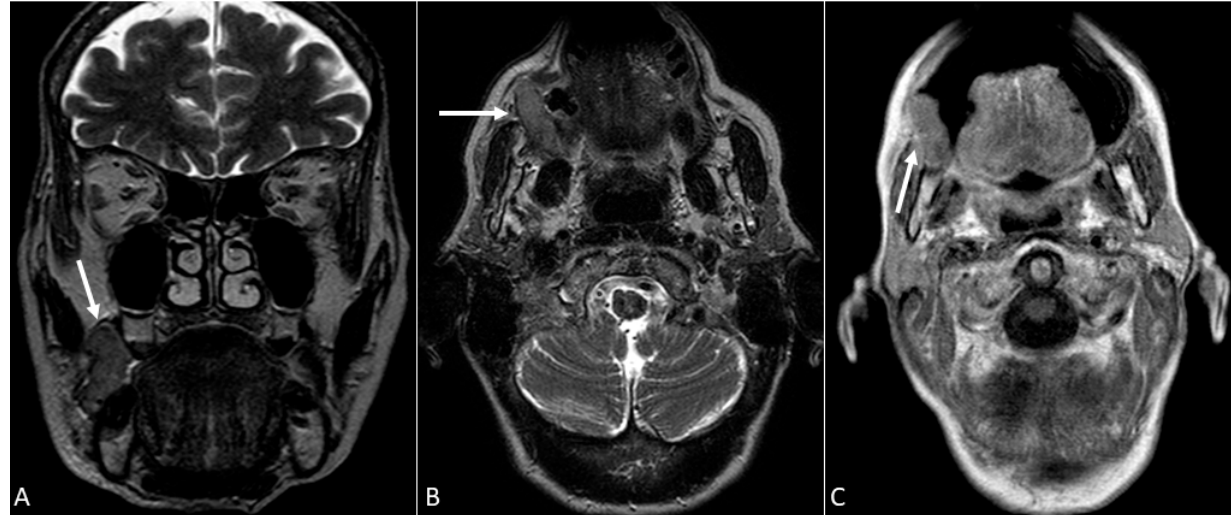
Figure 11. Puffed cheek technique. MRI. ( A ) Standard T2 coronal image; ( B ) standard T2 axial image. ( C ) Puffed cheek contrast-enhanced T1 axial image. Carcinoma of the right cheek mucosa (white arrows). Puffed cheek technique highlights the lesion and detached the margins of the lesion from the surrounding mucous structures well.